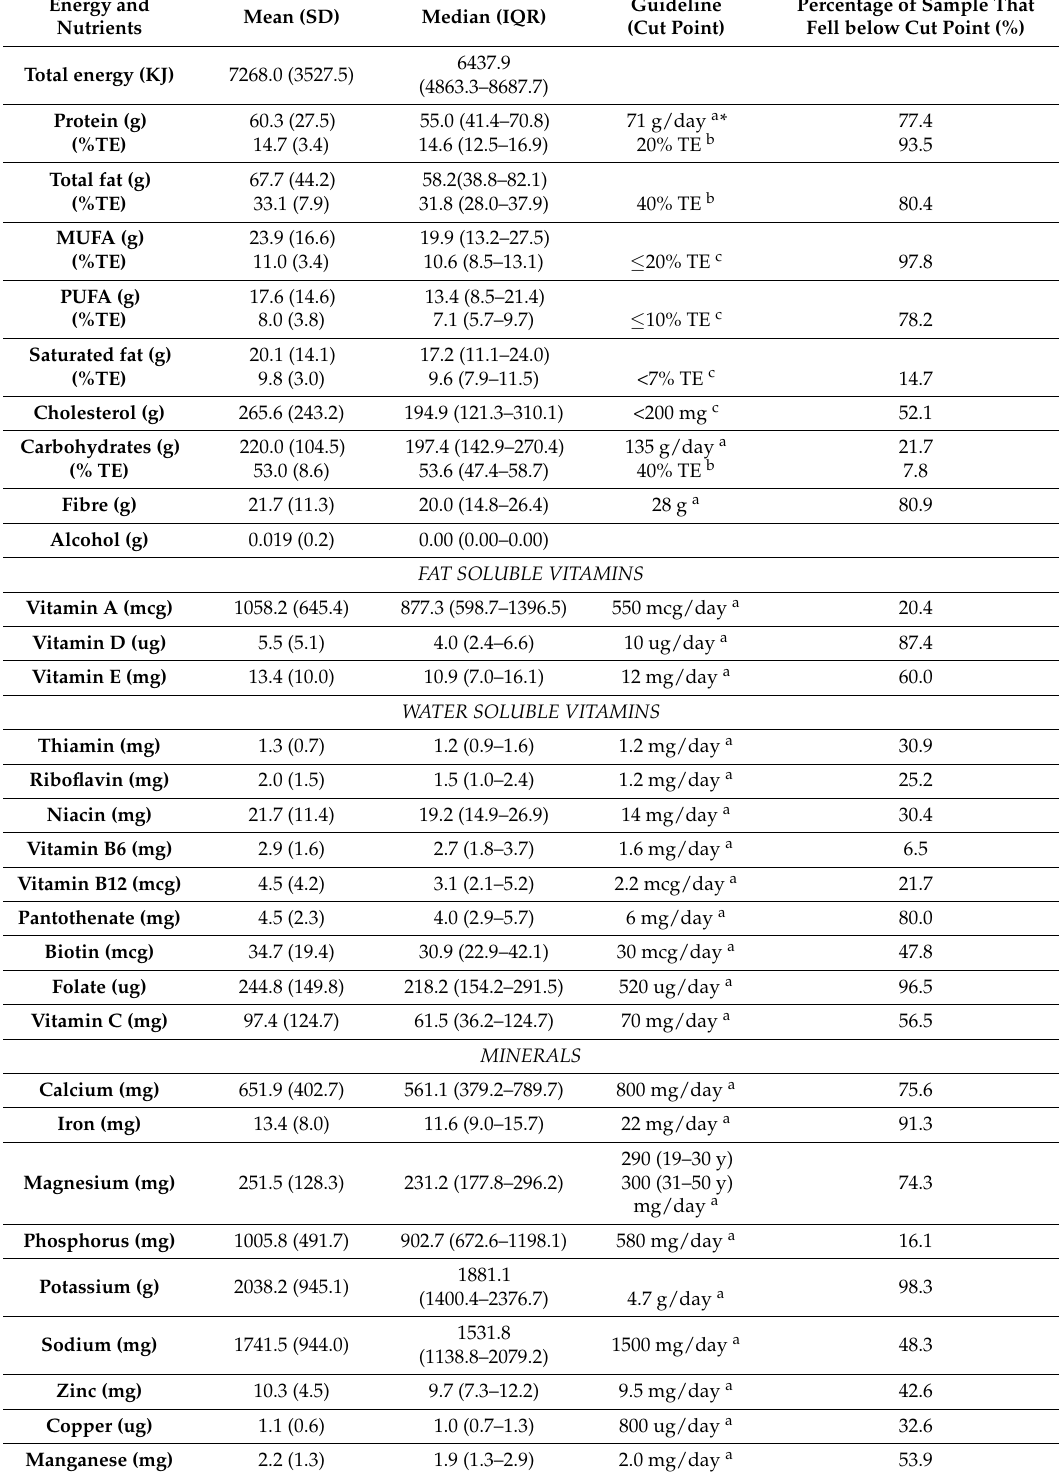
Table 3. Mean and adequacy of macronutrients, vitamins and mineral intake per day by the sample ( n = 230). Energy and